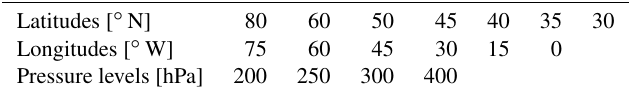
Table 1. Overview of the time-region grid points, where standardized emissions are released and specific local climate change functions are